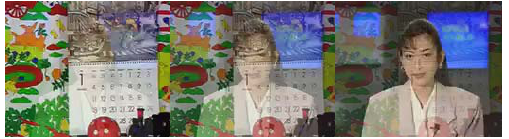
Figure 11. Mobile- Akiyo Superimposing attack using a merge factor (from left to right 0.2, 0.5, 0.8)